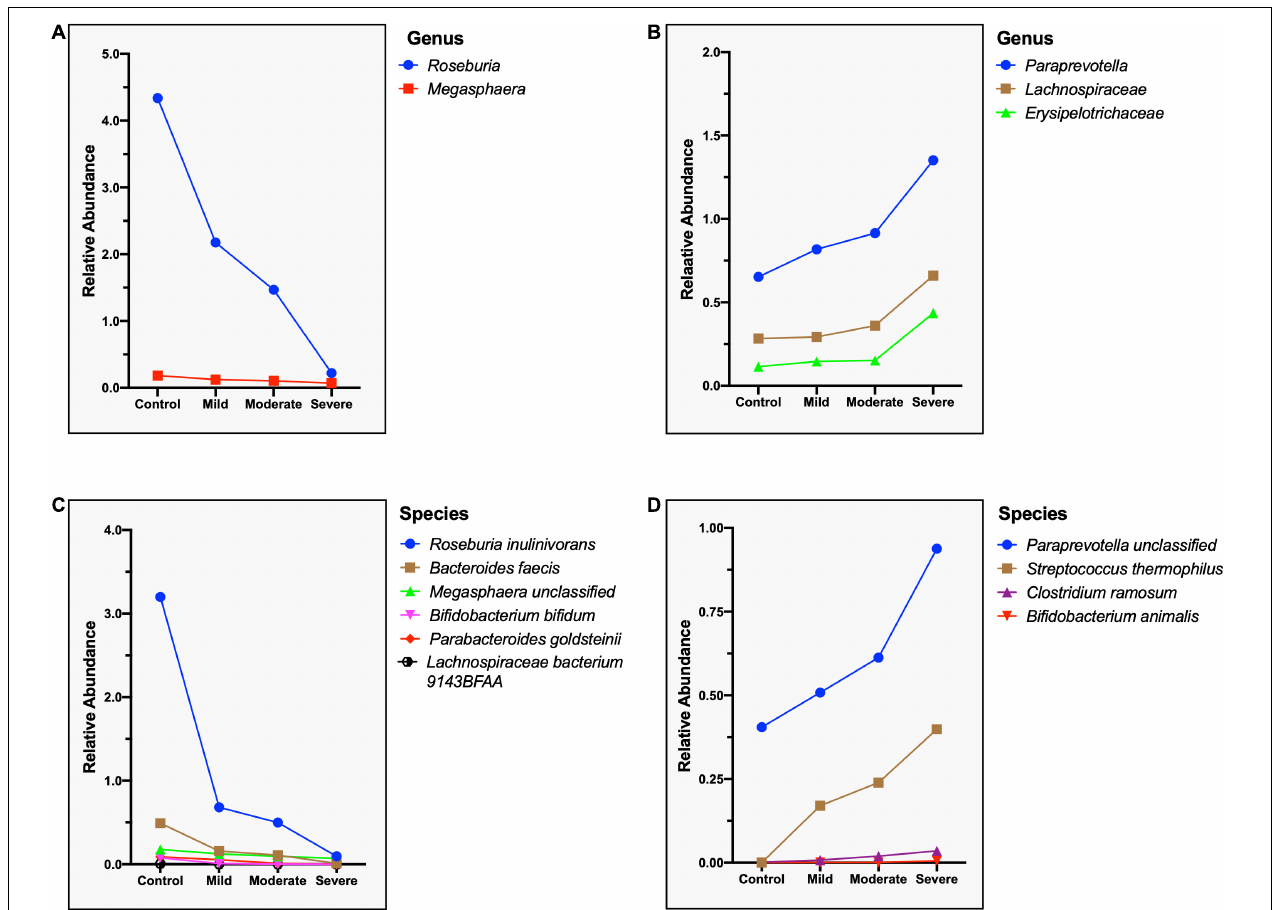
FIGURE 8 | Microbial genera and species related to the severity of the COVID-19. (A) Negatively correlated microbial genus with the severity of COVID-19, showing a steep decrease in the relative abundance of Roseburia . (B) Positively correlated microbial genus with the severity of COVID-19, showing a sharp increase in the relative abundance of Erysipelotrichaceae . (C) Negatively correlated microbial species with the severity of COVID-19, showing a steep decrease in the relative abundance of Roseburia inulinivorans . (D) Positively correlated microbial species with the severity of COVID-19, showing a sharp increase in the relative abundance of Paraprevotella sp. and Streptococcus thermophilus